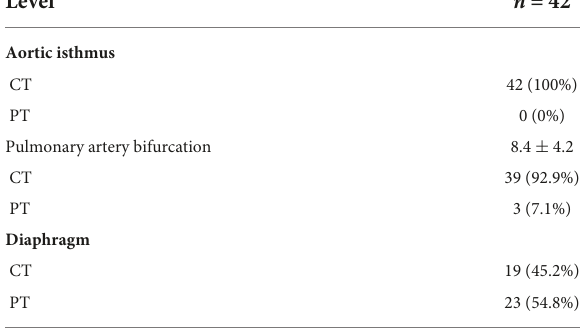
TABLE 3 False lumen thrombosis in 42 patients with aortic dissection.